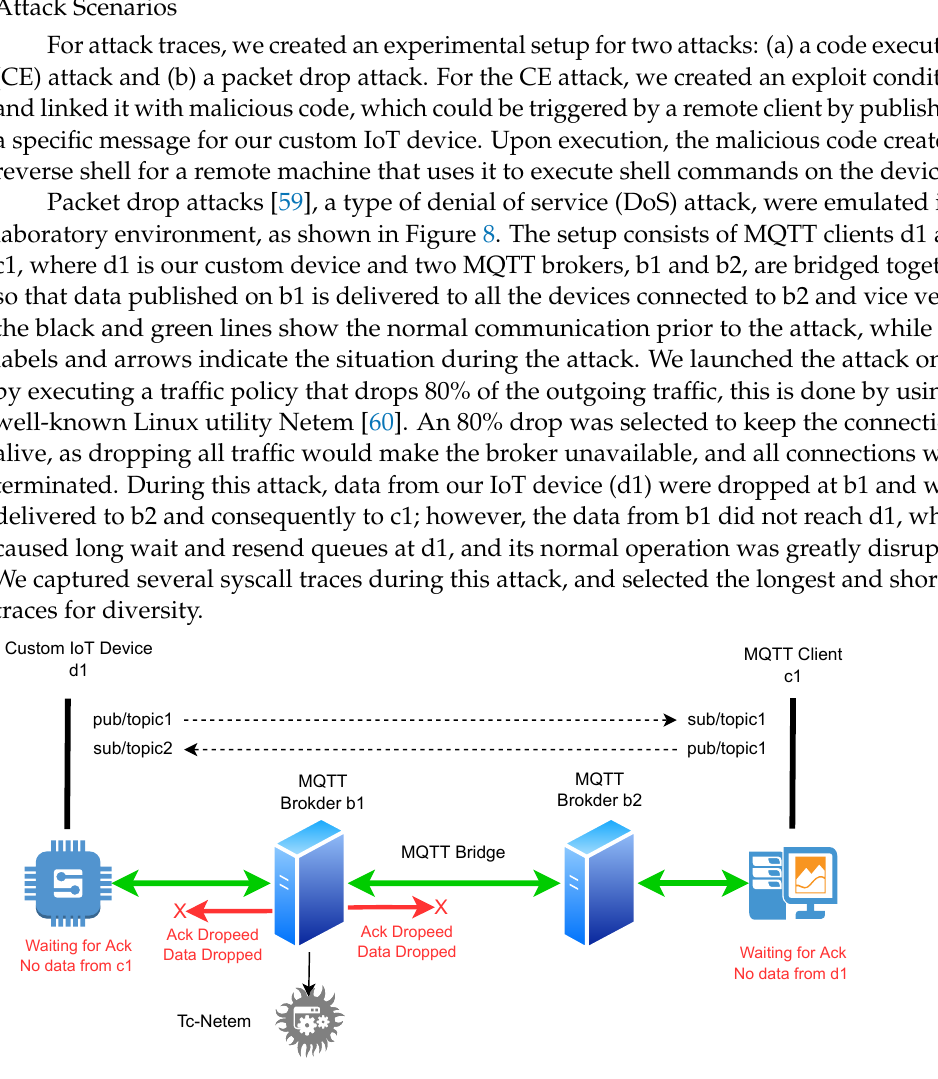
Figure 8. Laboratory setup for emulated denial of service (EDoS) attack on the custom IoT device. The black lines indicate the message settings, the green lines show normal MQTT traffic, and the red lines show the situations during the attack broker, b1, dropping traffic intended for d1 and